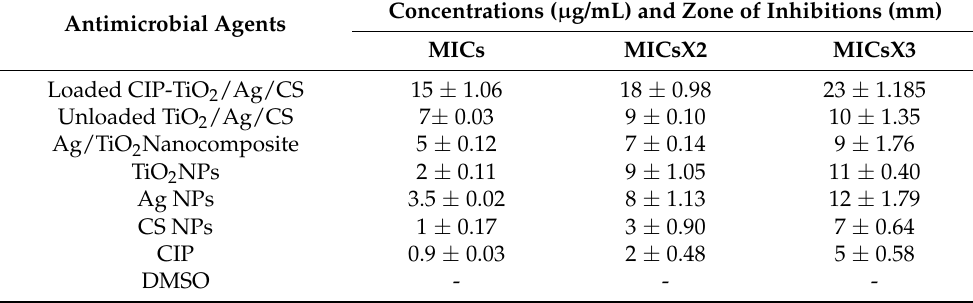
Table 1. Zone of inhibition and SD (Standard deviation) values of synthesized nanoformulations agents and synthetic antibiotic at various concentrations against MDR E. coli.